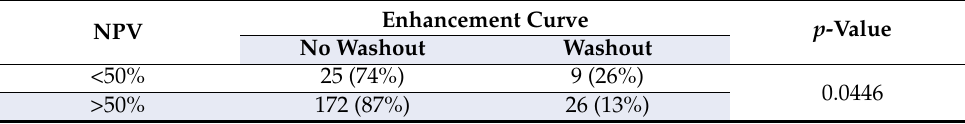
Table 6. NPV and enhancement curve—comparison (total of 232 cases).